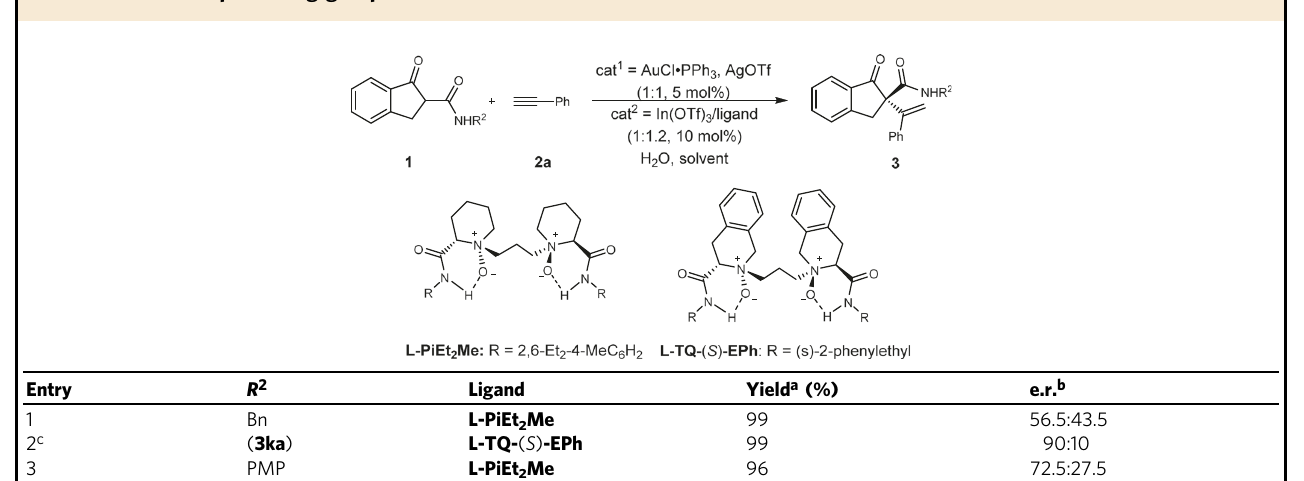
Table 2 Effect of N -protecting